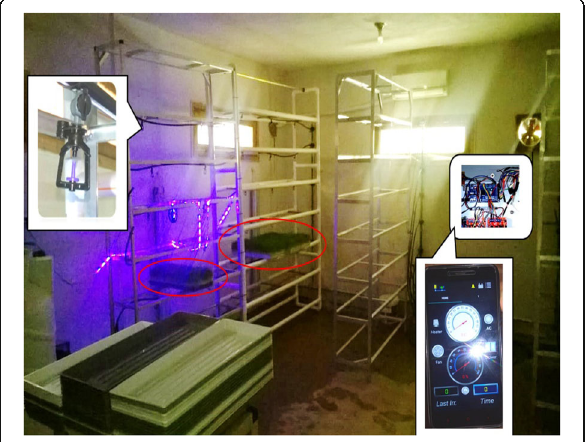
Fig. 1 Intelligent hydroponic chamber based on Internet